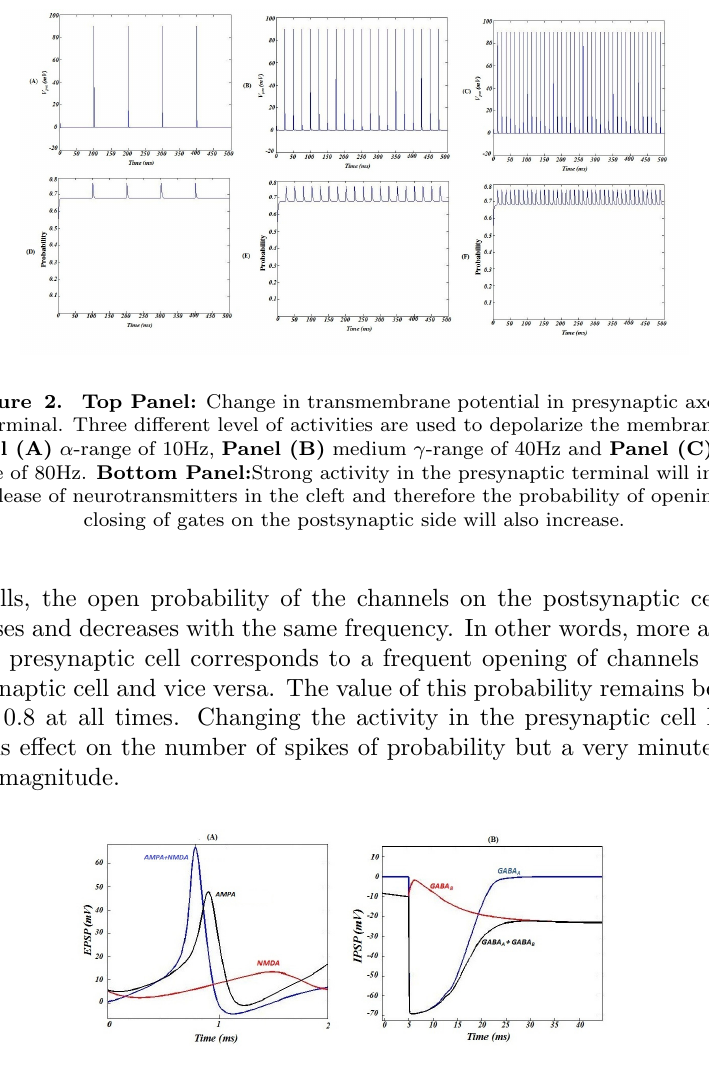
Figure 3. Comparison of spike characteristics of mediated currents in postsynaptic cell through different channels. Panel A: EPSP mediated by AMPA and NMDA channels. Panel B: IPSP mediated by GABA A and GABA B